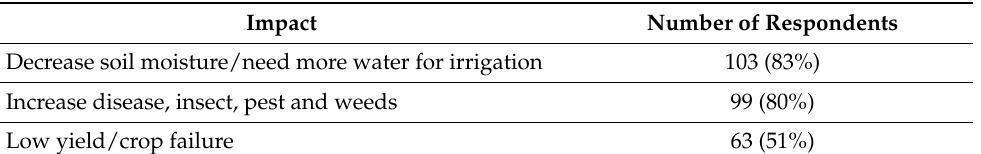
Table 6. Farmers’ perception of major impacts of climate change in the agriculture sector ( n = 124) in the study area.